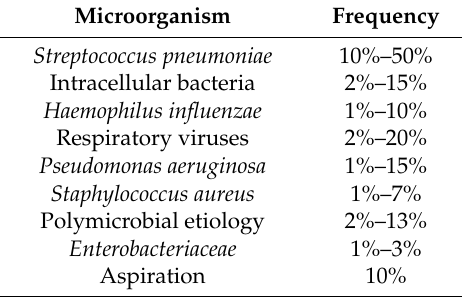
Table 3. Microbial etiology of Community-Acquired Pneumonia in the elderly patients [2,9,69,70,72,76].